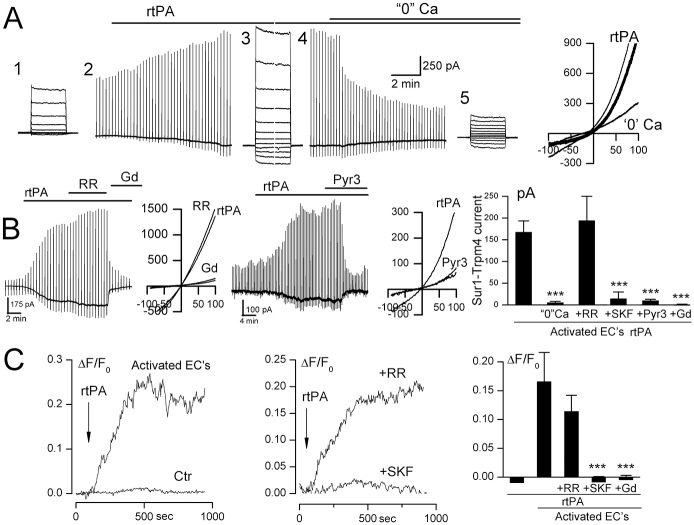
SUR1-TRPM4 channel opening by tPA requires Ca2+ influx via TRPC3.A: Macroscopic currents during 200-ms step pulses (#1,3,5) and ramp pulses (–100 to +100 mV; 4 mV/msec) (#2,4), induced by recombinant tPA (rtPA) in activated murine BEC, recorded initially using extracellular solution with 1.8 mM Ca2+, and after switching to extracellular solution containing 0 mM Ca2+; right: illustrative currents during ramp pulses after addition of rtPA, before and after switch to 0 Ca2+; the difference current is also shown (thick line). B: rtPA-induced current in activated BEC was not blocked by ruthenium red (RR), but was blocked by Gd+3 and Pyr3; illustrative currents during ramp pulses after addition of rtPA, before and after Gd+3 or Pyr3 are also shown; bar graph: rtPA-induced currents in activated BEC in the presence of 1.8 mM Ca2+, 0 mM Ca2+; 1.8 mM Ca2+ plus RR or SKF-96365 or Pyr3 or Gd3+; cells/condition for each bar: 25, 7, 5, 7, 5, 7. C: Change in intracellular Ca2+ concentration (ΔF/F0) induced by rtPA in activated but not in non-activated (Ctr) BEC; the rtPA-induced increase in Ca2+ was blocked by pretreatment with SKF-96365 but not RR; bar graph: mean change at 10–12 minutes in intracellular Ca2+ concentration induced by rtPA in non-activated and activated BEC, in the presence of RR; SKF-96365; Gd3+; cells/condition for each bar: 10, 8, 10, 10, 10; ***, P<0.001.